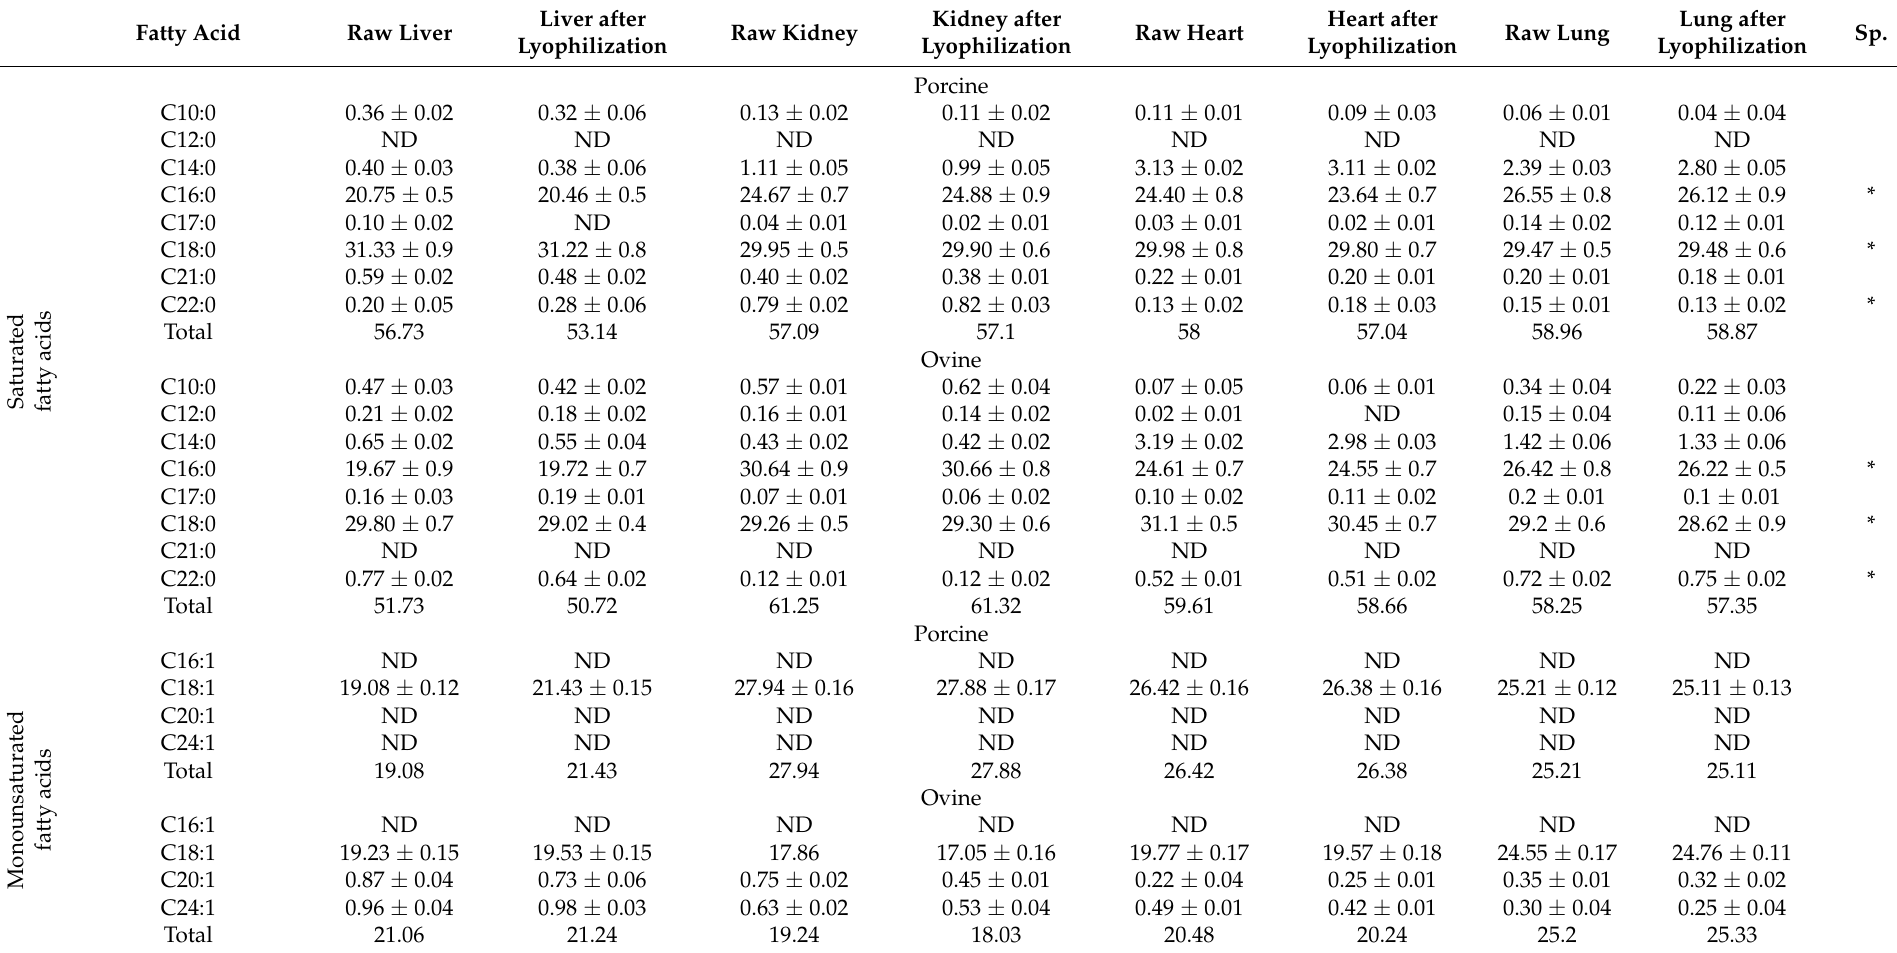
Table 3. Composition of fatty acids in raw and lyophilized meat by-products (% of total fatty acid